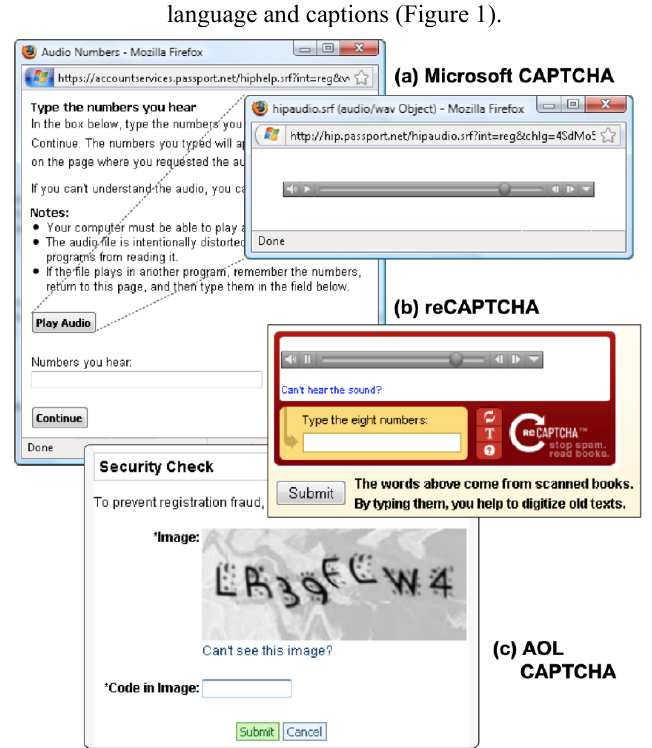
Figure 1. Examples of CAPTCHAs interfaces